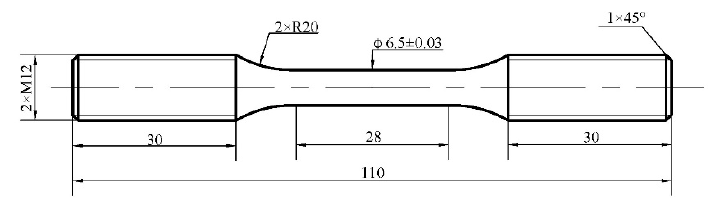
Figure 3. Low cycle fatigue (LCF) test sample.